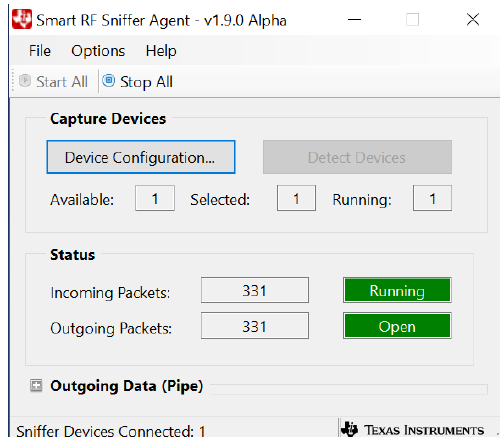
Figure 4. SmartRF Packet Sniffer GUI.